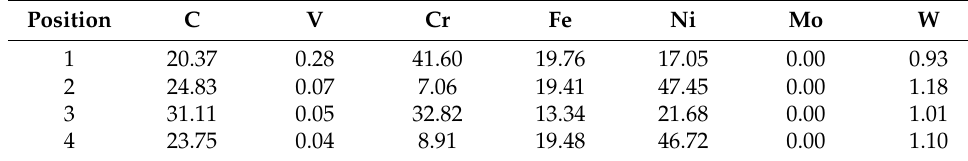
Figure 6. The microstructure of the coating. ( a ) Cross-sectional morphology of the coating. The dendrite (1, 3 points) and the inter-dendrite (2, 4 points); ( b ) result of the line scan; ( c ) magnified microstructure of the cladding layer. Table 3. EDS results of different positions in the cladding layer